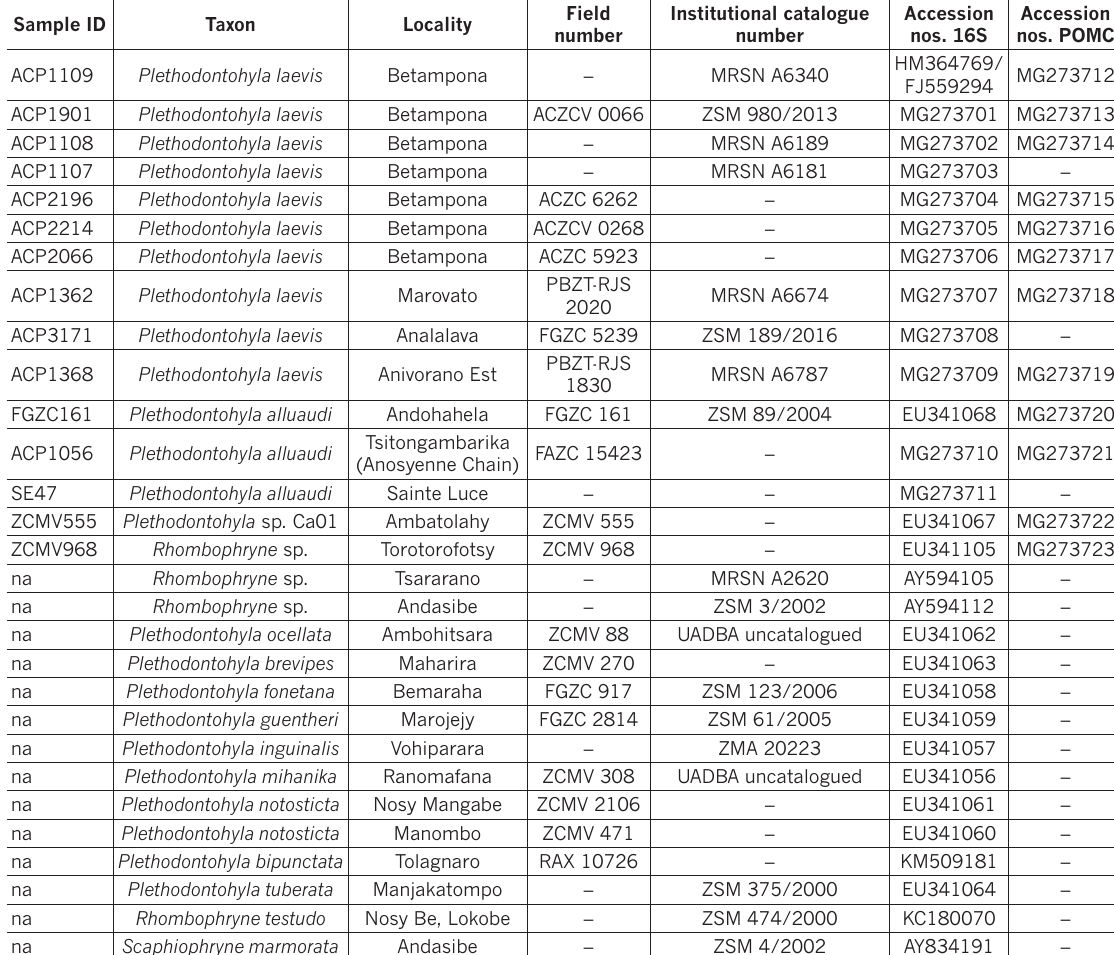
Table 2. List of samples included for the molecular analyses with their respective localities, voucher and/or field number informa - tion, institutional catalogue number (where available) and GenBank accession